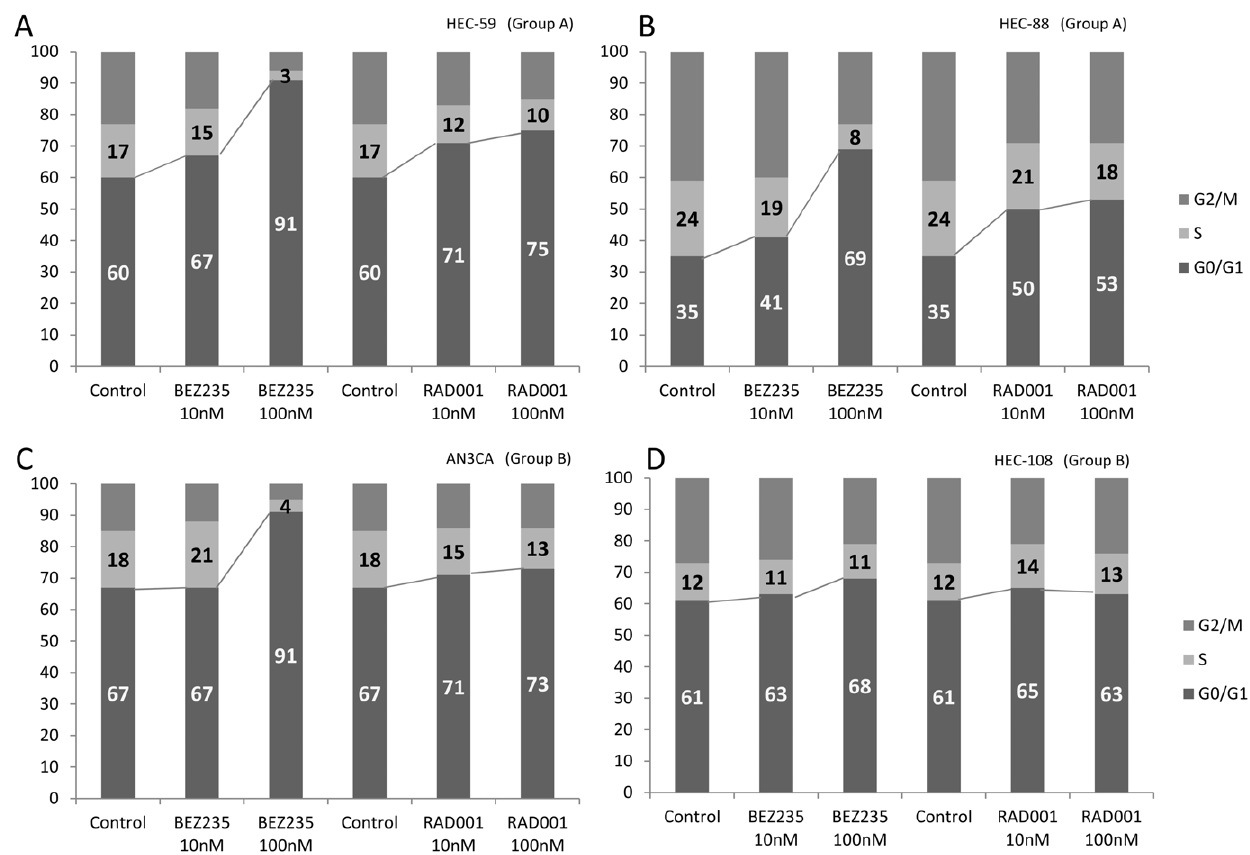
Figure 4. Flowcytometric analysis of cell cycle in cancer cells treated with either NVP-BEZ235 or RAD001. (A–D) Cells (5 6 10 5 ) were seeded in the presence of 10% serum and treated with NVP-BEZ235 or RAD001 for 48 h at a dose of 10 nM or 100 nM, respectively. A higher dose of NVP-BEZ235 (100 nM) significantly augmented the percentage of cells in the G0-G1phase of the cell cycle, compared with that of RAD001 (100 nM). (A)–(B); The data from two group A cells. (C)–(D); the data from two group B cells.